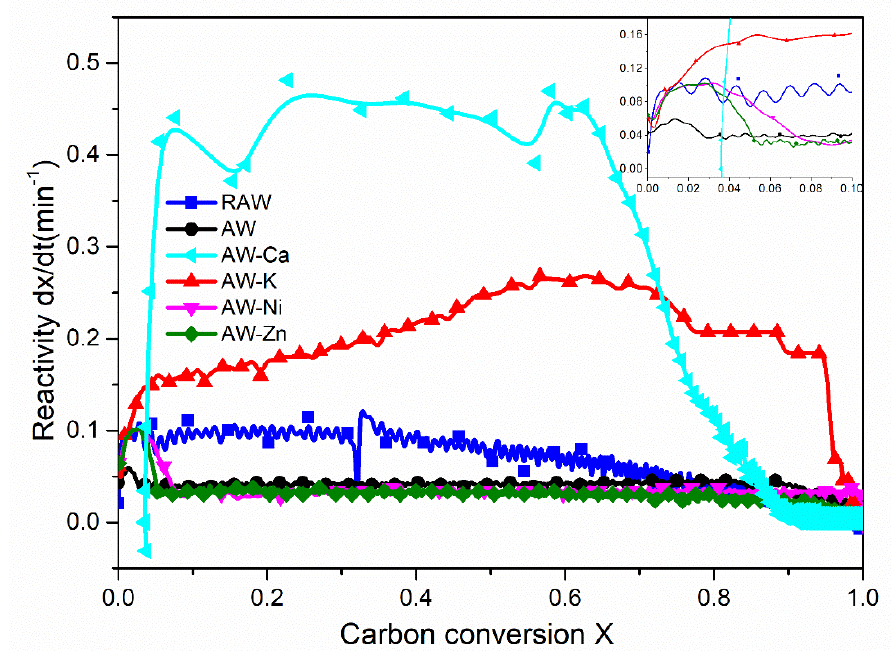
Figure 3. Gasification reactivity of different added metal chlorides versus conversion profiles at 1000 °C (The insert figure is a zoom of the carbon conversion at 0–0.1).